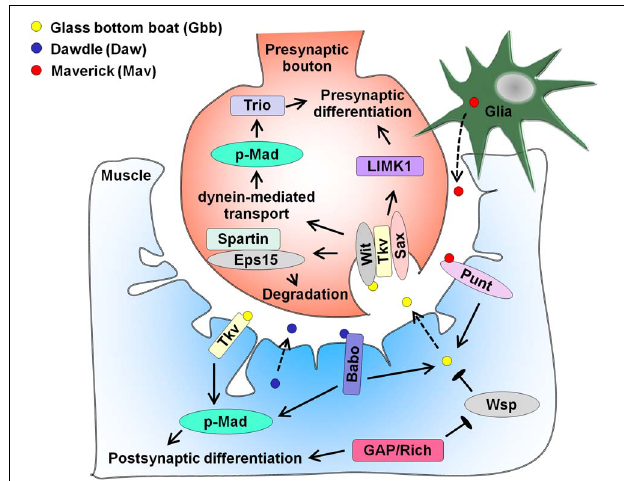
FIGURE 3 | Bone Morphogenetic Protein (BMP) homolog Glass bottom boat (Gbb), activin ligand Dawdle (Daw), and TGF- β ligand Maverick (Mav) regulate larval NMJ differentiation. Gbb secreted from the muscle (dotted arrow) signals through pre-synaptic BMP receptors wishful thinking (Wit), thickveins (Tkv), and saxophone (Sax) to enhance synaptogenesis. Gbb binding activates LIMK1 and dynein-mediated retrograde axonal transport of the BMP receptors leads to phosphorylation of the Mad transcription factor, thus driving pre-synaptic differentiation. One of the downstream targets of phosphorylated Mad (p-Mad) is the Rac GEF Trio. Gbb signaling is inhibited by spartin, which binds endocytic adaptor Eps15 and enhances endocytic degradation of Wit. Cysteine-rich transmembrane BMP regulator 1 homolog, the inhibitory Smad Dad, and Highwire are additional negative regulators of Gbb signaling absent from this figure. Gbb also binds Tkv in muscle and regulates gene expression through p-Mad. Apart from Gbb, muscle-derived Daw (dotted arrow) binds Baboon (Babo) to enhance post-synaptic differentiation, while promoting Gbb expression to drive pre-synaptic differentiation. Lastly, glia-derived Mav (dotted arrow) binds Punt and augments Gbb transcription and release. In addition, the Cdc42-selective GAP Rich inhibits the Cdc42 effector Wiskott-Aldrich syndrome protein Wsp, thus stimulating Gbb secretion from the muscle. Rich also promotes post-synaptic development independently of